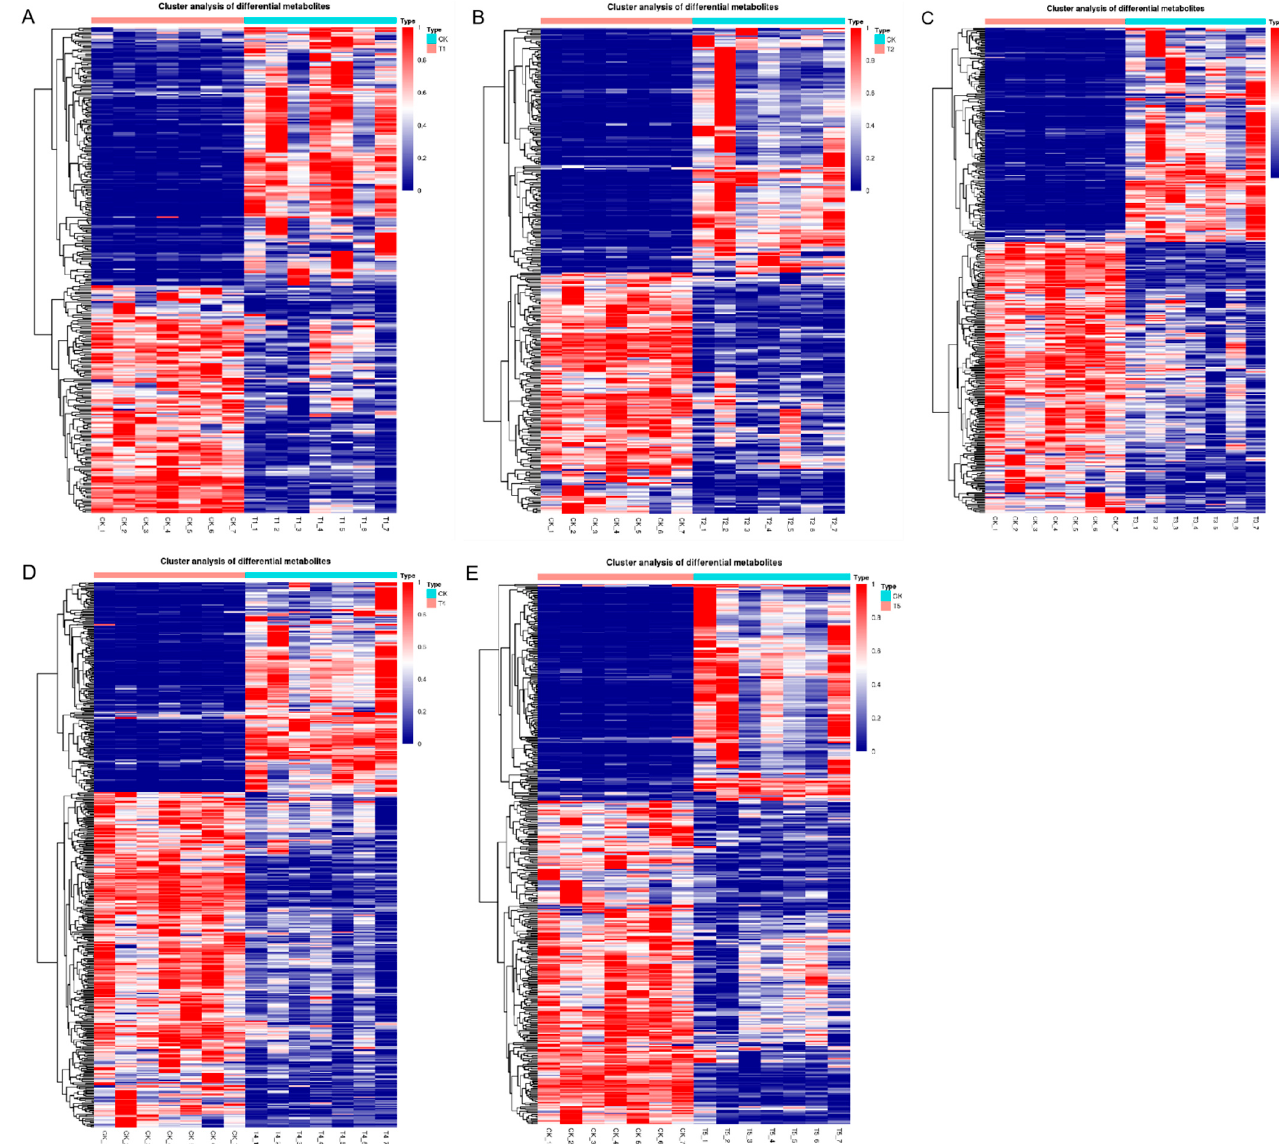
Figure 3. Hierarchical clustering heatmap visualizing the changes in the contents of potential metabolites in grains after different hyphal development stages in Tilletia laevis infection. ( A ) CK vs. T1 group. ( B ) CK vs. T2 group. ( C ) CK vs. T3 group. ( D ) CK vs. T4 group. ( E ) CK vs. T5 group. CK stands for control, QC stands for quality control, T1 stands for suspension of teliospores, T2 stands for promycelia, T3 stands for primary basidiospores, T4 stands for H-bodies, and T5 stands for secondary basidiospores.